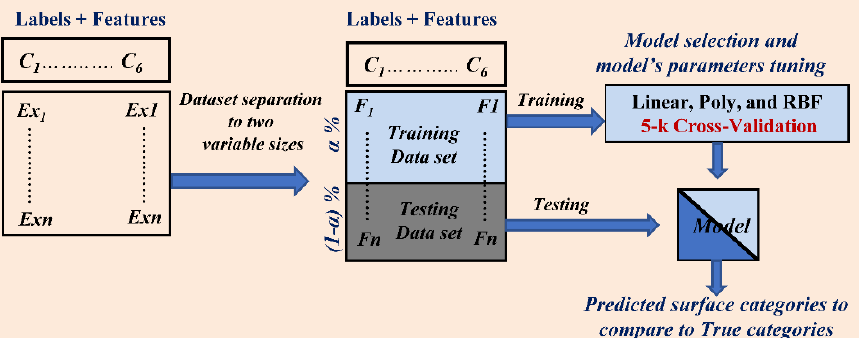
Figure 20. Block diagram depicting the procedure for learning and testing the support vector machine (SVM) model.